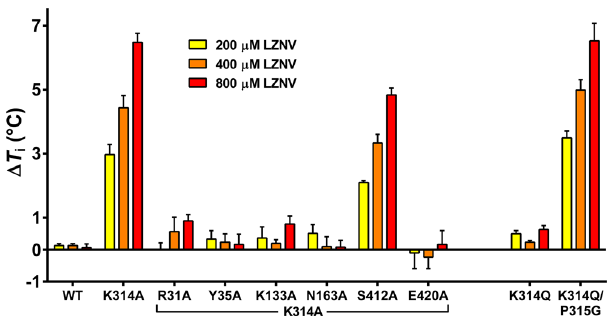
Fig. 5 Thermal stabilisation of different YePEPT variants by LZNV. The T i -values of different YePEPT variants were determined at three different concentrations of LZNV, i.e., 200 µ M, 400 µ M and 800 µ M. Δ T i -values at the speci fi ed LZNV concentrations were determined by subtraction of the T i -value in the absence of LZNV. Data points represent mean ± SD of at least three